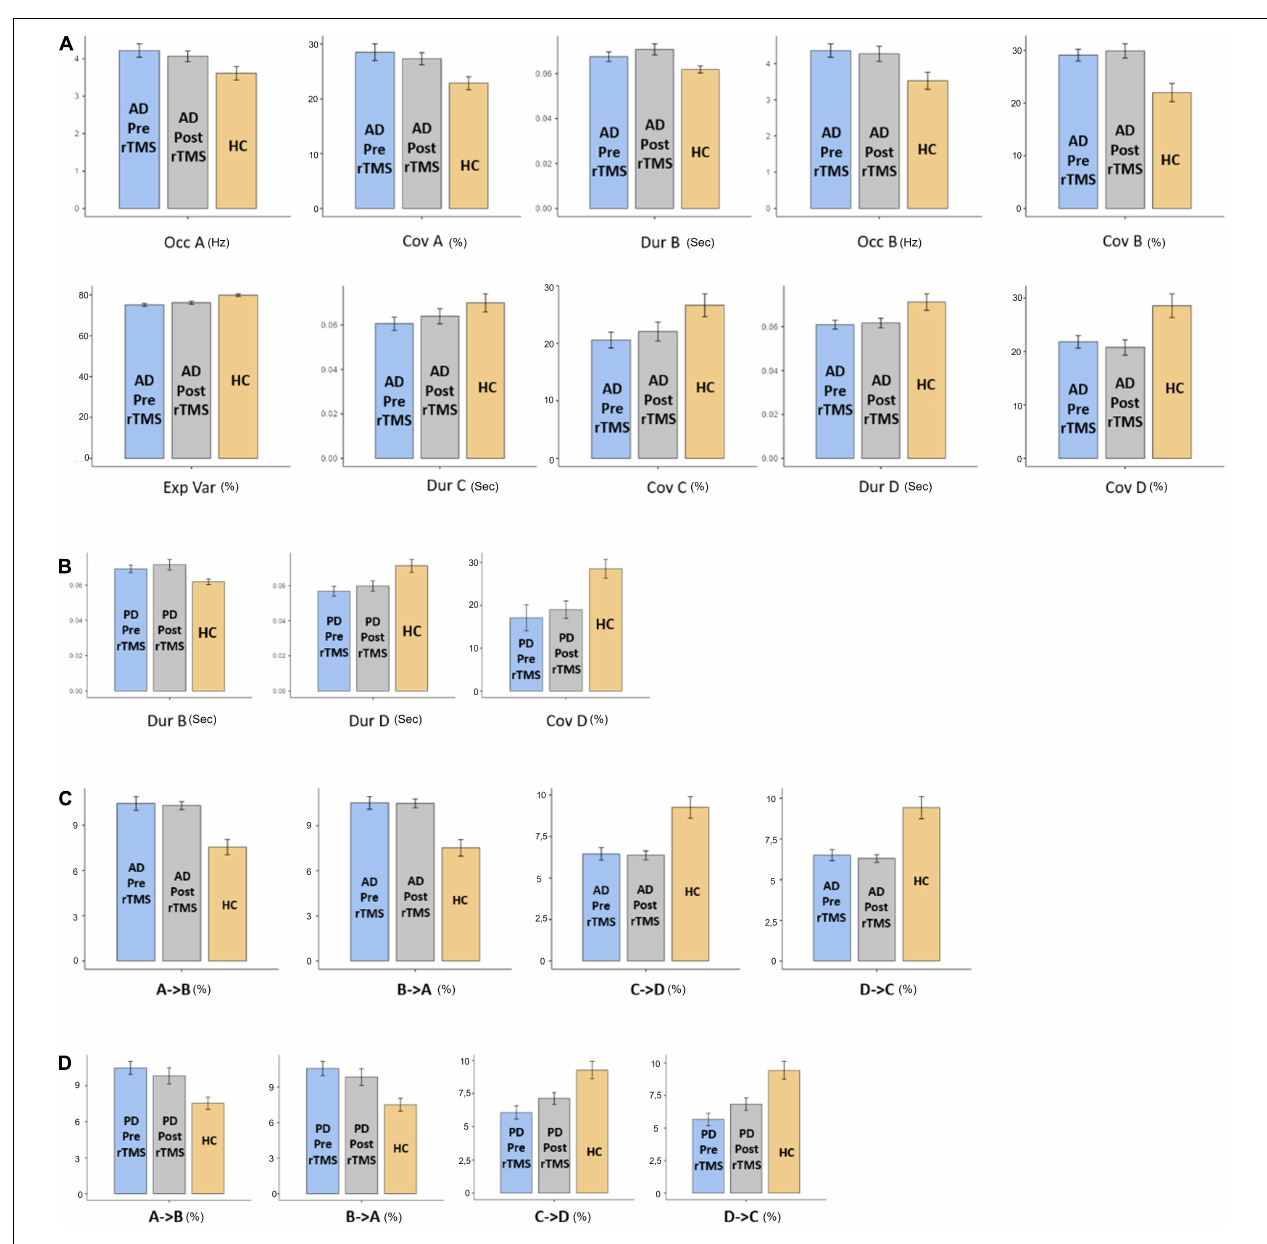
FIGURE 2 | The statistics results of (A) AD and (B) PD groups of microstate characteristic as duration (Dur), explained variance (Exp Var), coverage (Cov) of microstate as A, B, C, and D transitions between microstates for (C) AD and (D) PD groups. “ → ” represents transitions between microstates.